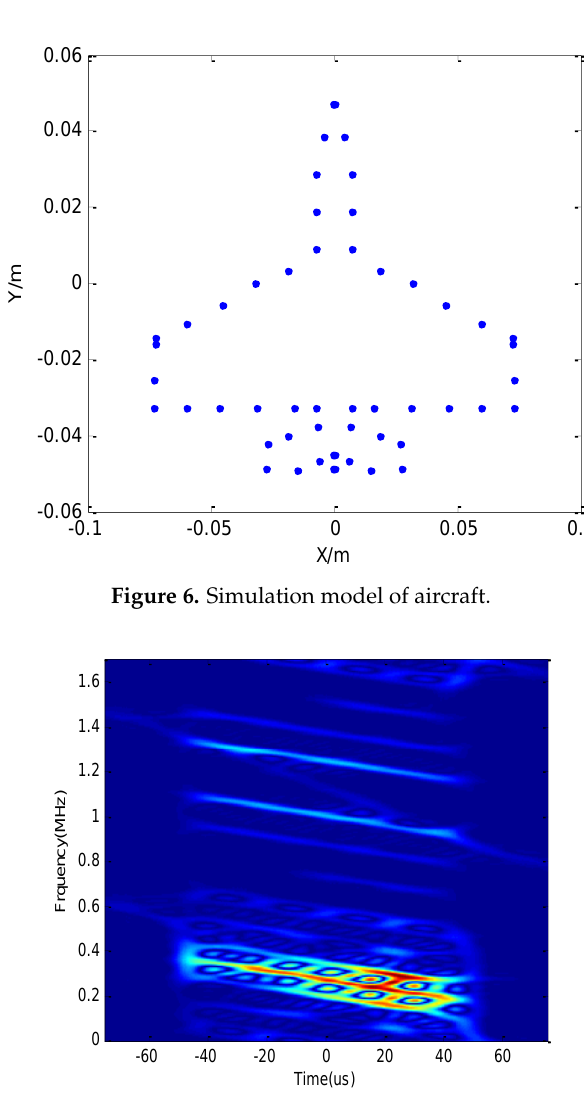
Figure 7. The 128th pulse’s smooth pseudo Wigner distribution (SPWVD).